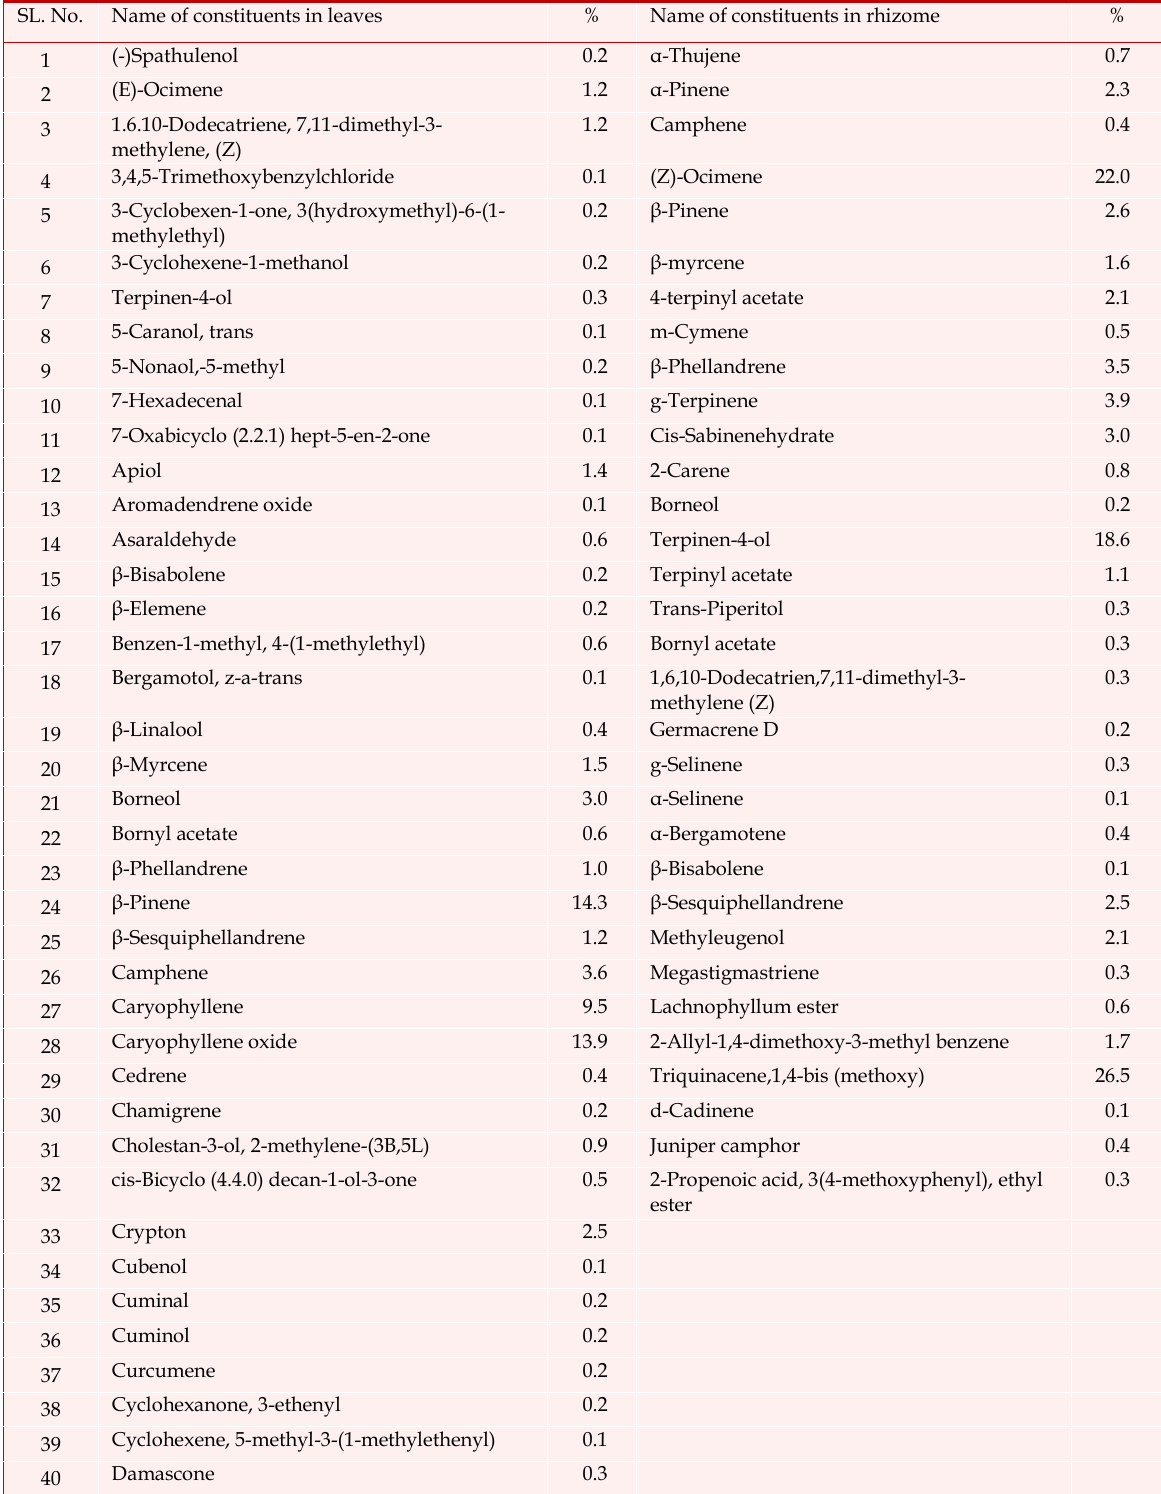
Constituents of essential oil from the leaf and rhizome of Zingiber